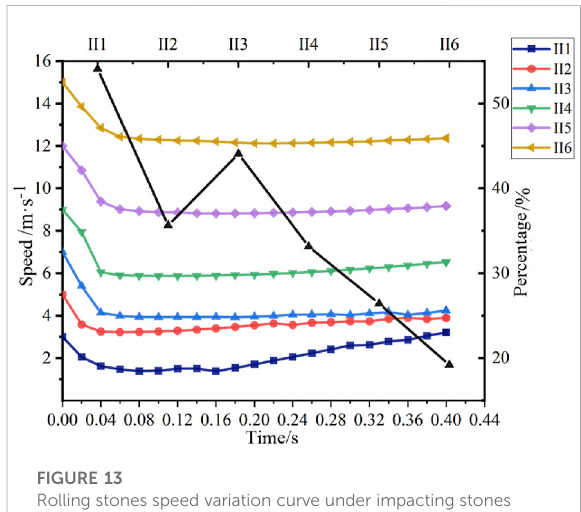
FIGURE 13 Rolling stones speed variation curve under impacting stones with different initial